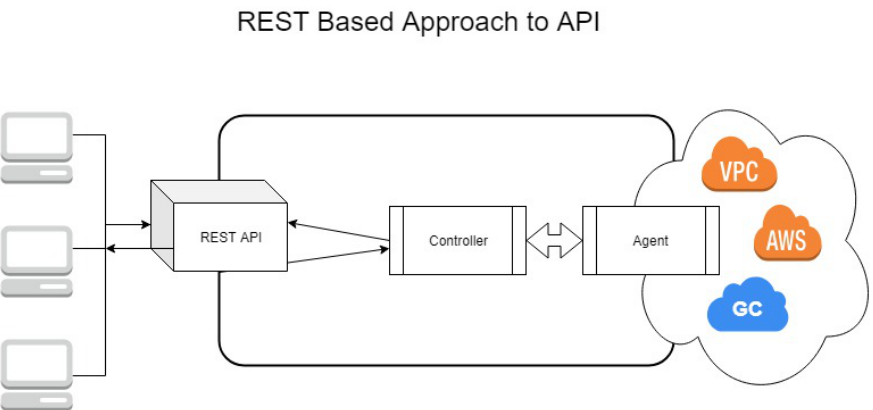
Sensors 2021 , 21 , x FOR PEER REVIEW Figure 1. REST API Architecture with Multi-Cloud Application. Figure 1. REST API Architecture with Multi-Cloud Application.